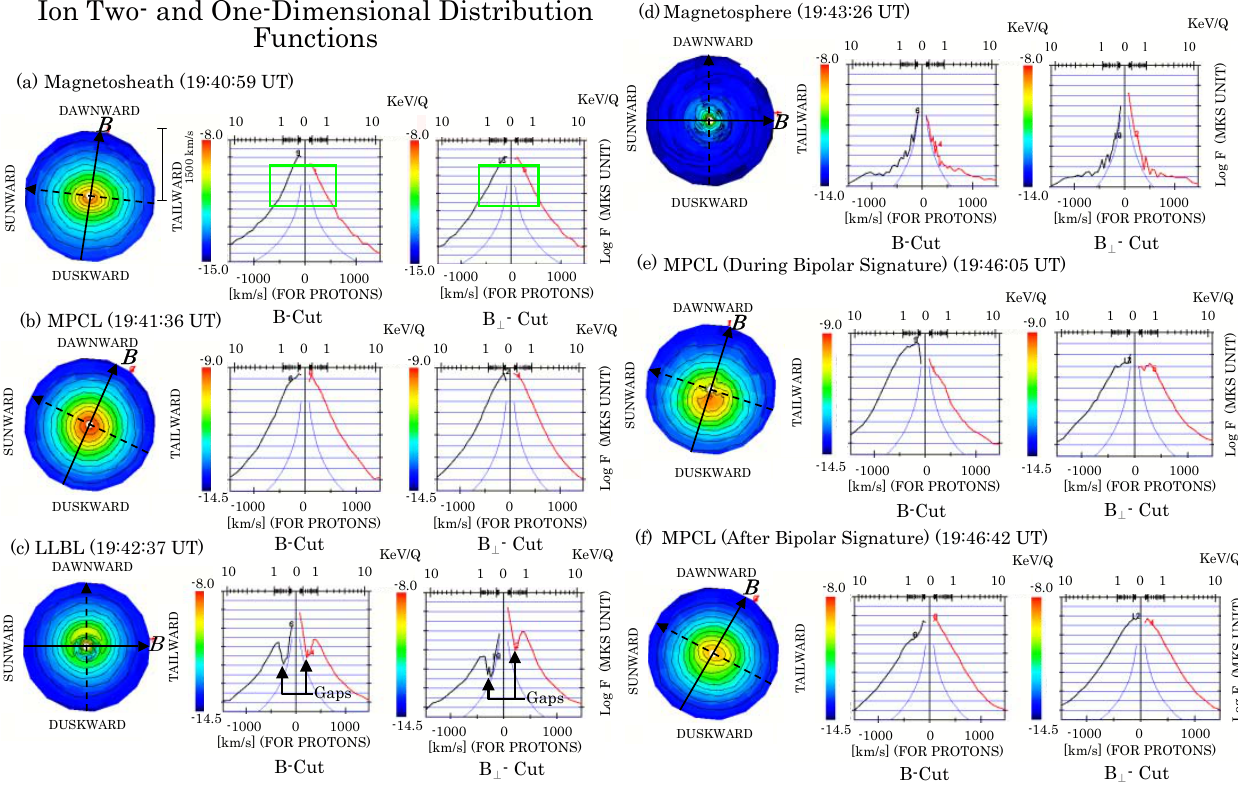
Fig. 6. Two- and one-dimensional ion distribution functions in the ( a ) magnetosheath ( b ) first MPCL, ( c ) LLBL, ( d ) magnetosphere, ( e ) second MPCL during the interval in which the B n bipolar signature can be found, and ( f ) second MPCL after the B n bipolar signature disappears. The left-hand panel shows the two-dimensional distribution function projected onto an equatorial plane. The upper, lower, left- and right-hand sides correspond to the dawnward, duskward, sunward and antisunward (tailward) directions, respectively. The color code is assigned according to the logarithm of phase space density in units of m − 6 s 3 . The direction of the magnetic field lines projected onto an equatorial plane (shown with B) and the direction perpendicular to B are also superimposed on the distribution function. The middle and right-hand panels show the one-dimensional distribution functions cut along the B direction (B-cut) and the direction perpendicular to B (B ⊥ -cut), respectively. The lower, upper and left-hand axes provide the ion bulk velocity (km/s), its corresponding energy (keV/Q) and the logarithm of the phase space density (m − 6 s 3 ) which corresponds to the color of the color bar, respectively. The positive directions are shown by the